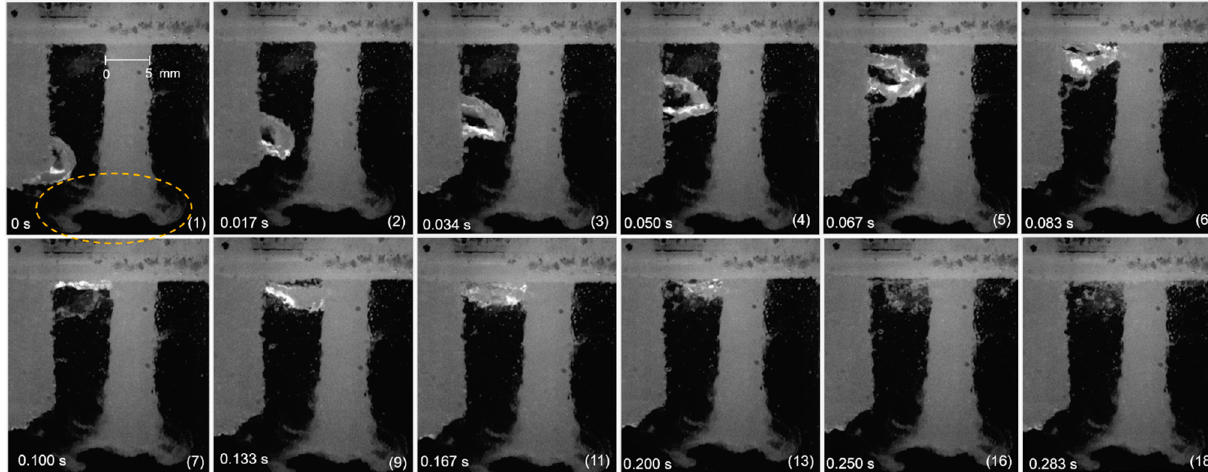
Figure 9. A bubble rising after its detachment from the horizontal surface, bouncing and bursting at the bath surface during electrolysis at a constant cell voltage of 1.5 V with the average current density of 0.4 A cm − 2 . The frame rate was 60 fps. Frame numbers are placed in brackets. Frame (1) is defined as 0 s right after the bubble was detached from the anode surface. A scale bar is shown in frame (1).